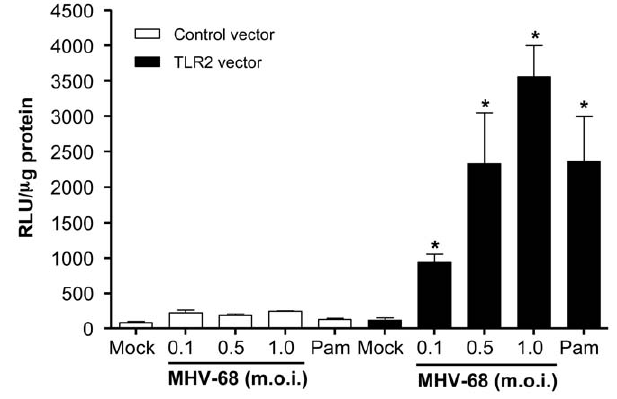
Figure 1. MHV-68 activates TLR2 in transfected HEK293 cells. HEK293 cells were transiently transfected with either murine TLR2 or control plasmid (400 ng) along with NF- k B luciferase reporter plasmid (100 ng). Forty-eight hours post-transfection, cells were stimulated with mock, infectious MHV-68 (m.o.i. 0.1, 0.5 and 1) or Pam 3 CSK 4 (Pam, 1 m g/ ml) for 6 hours followed by luciferase assay. Data are representative of two different experiments. Values that were significantly different ( p , 0.05) from mock control are indicated